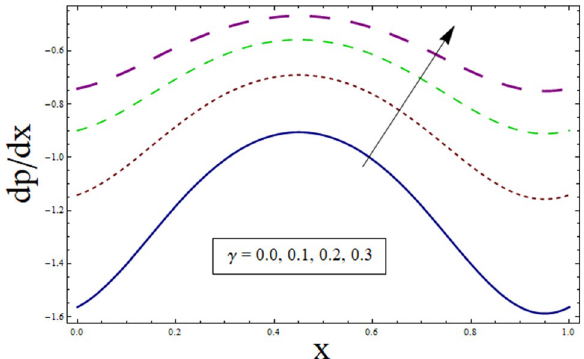
Figure 16. dp/dx for γ